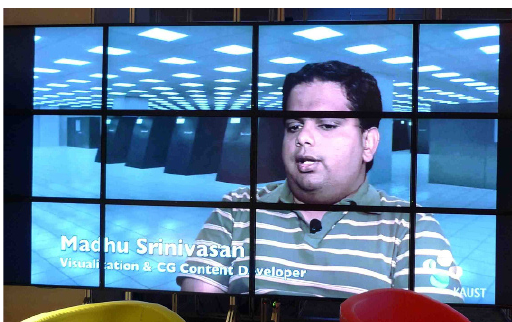
Figure 10. Conventional thick-bezel OptIPortal mullions obscuring the image. The CGLX VideoBlaster module is used. Video content: April Bailey. Photo: Tom